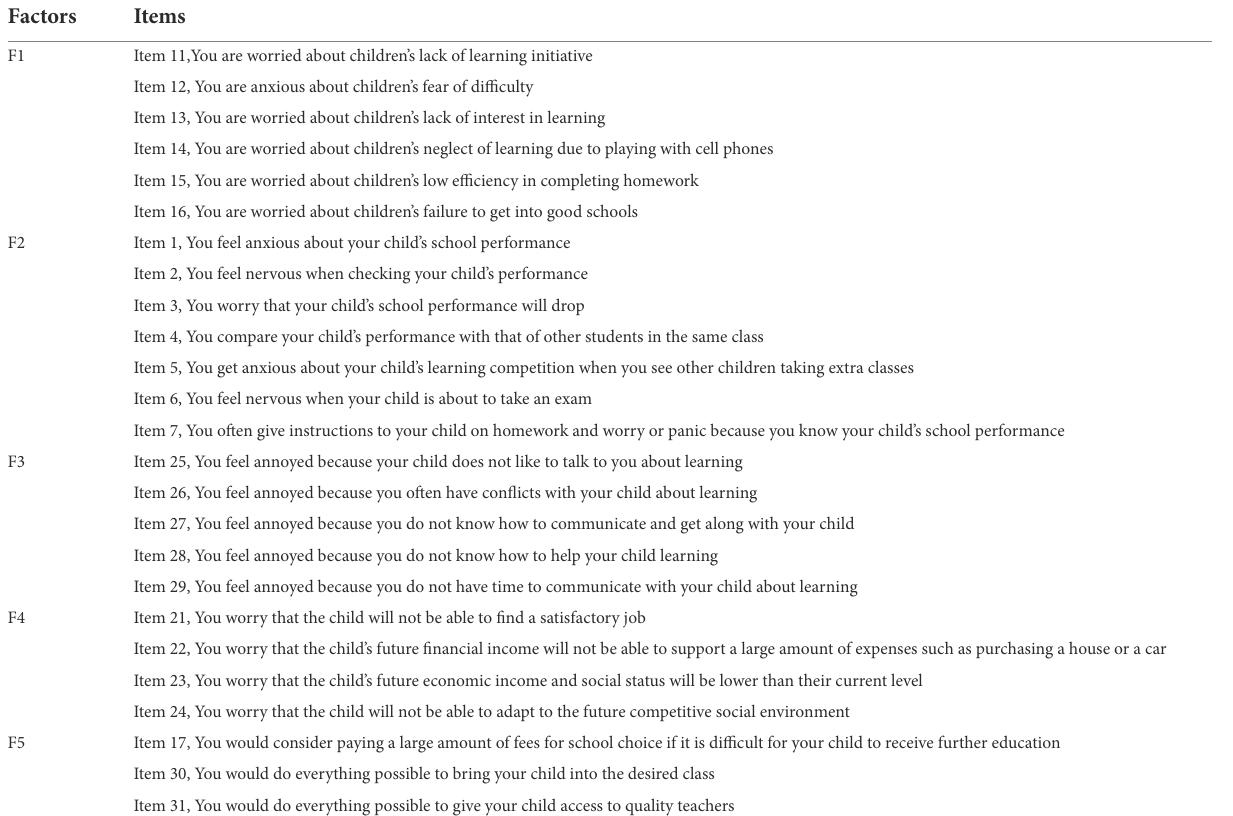
TABLE 8 Factors and items of the